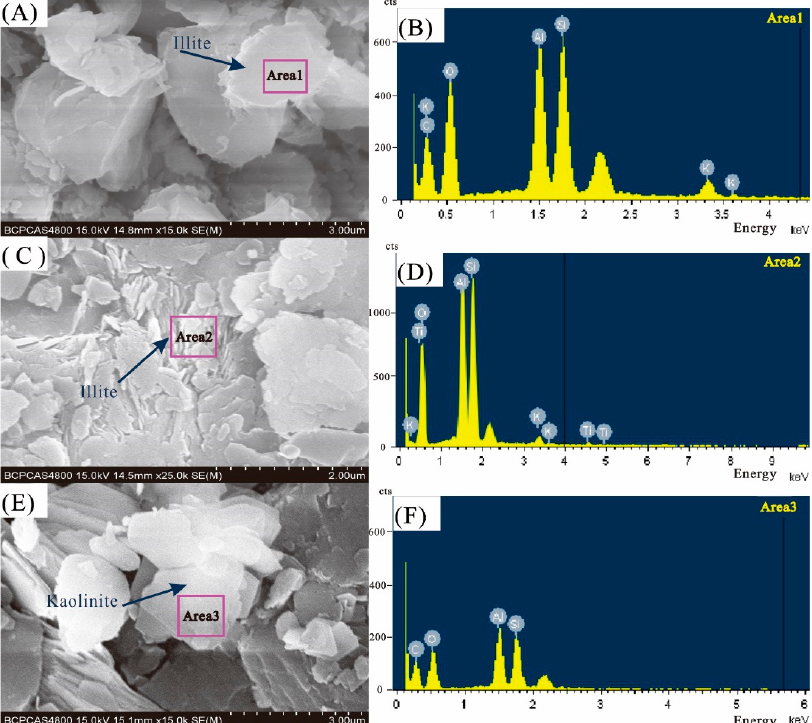
Figure 9. SEM images (under “SE mode”) and EDS spectrum of clay minerals. ( A,B ) Illite, dample HB-13; ( C,D ) illite, sample HB-8; ( E,F ) kaolinite, sample HB-23. Note that the unlabeled peak in each spectrum is due to Au, which was used for the sample coating.